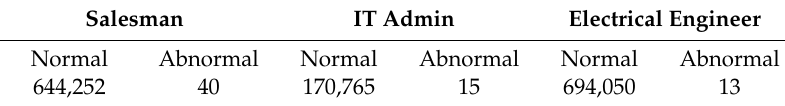
Table 8. Normal (0) and abnormal (1) e-mail count for the three roles. Salesman IT Admin Electrical Engineer Normal Abnormal Normal